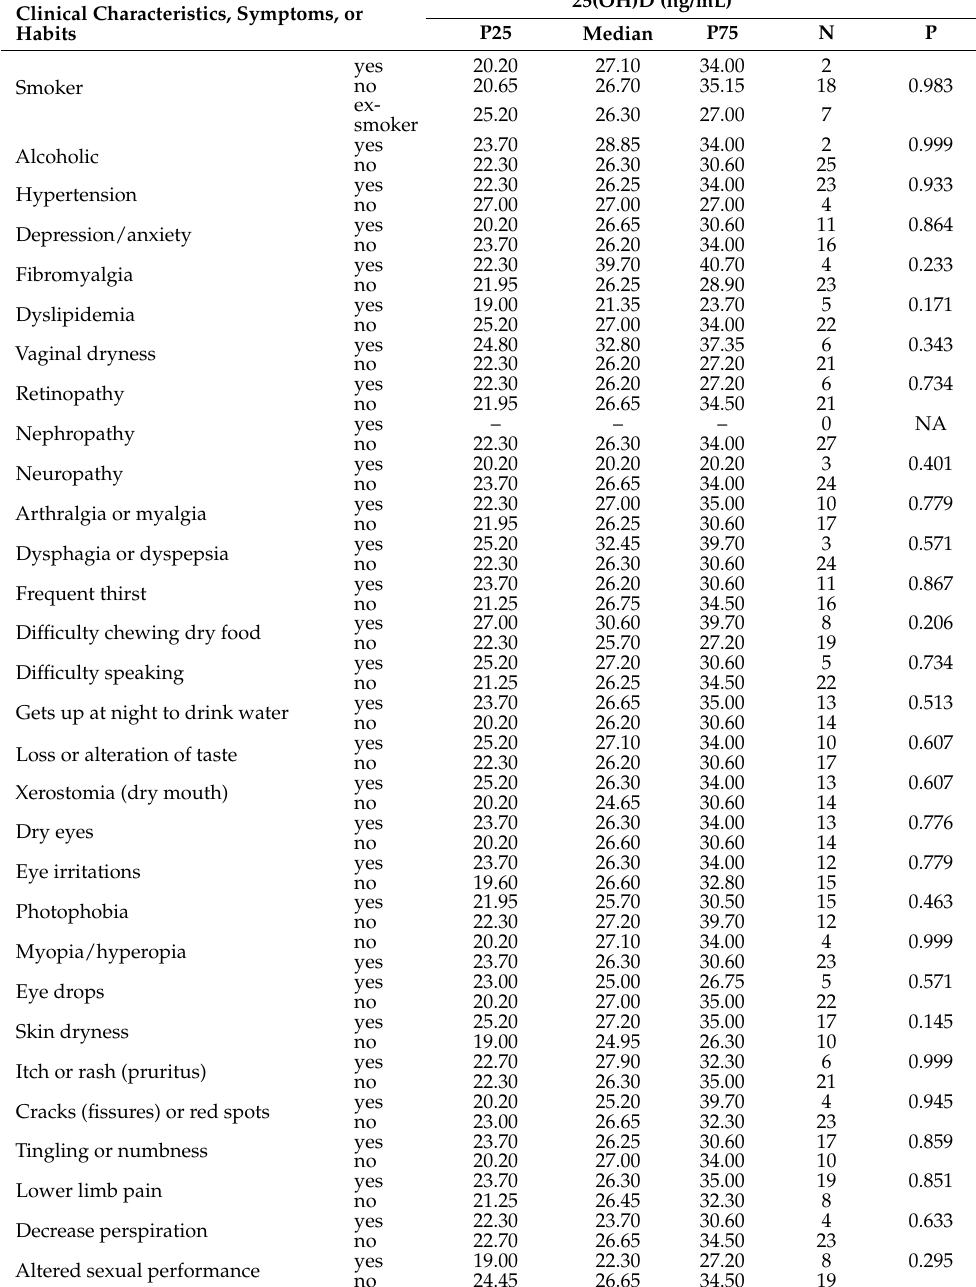
Table 2. Participants’ vitamin D [25(OH)D] serum levels according to the presence/absence of other clinical characteristics, symptoms, or